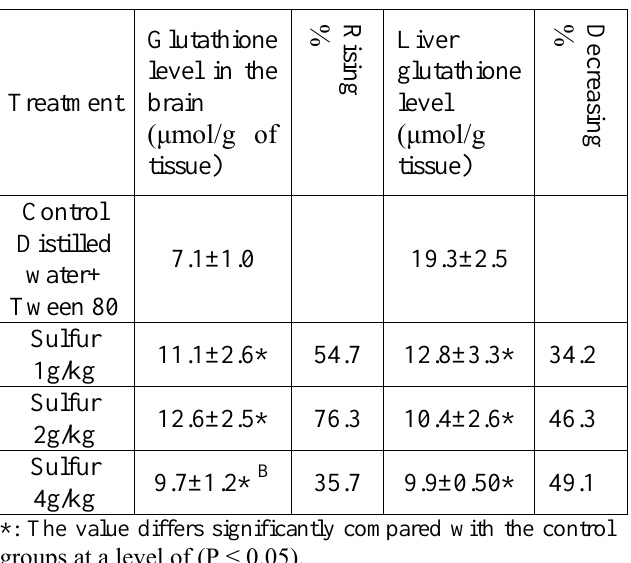
Table 4: Sulfur effects on the brain and liver glutathione level in